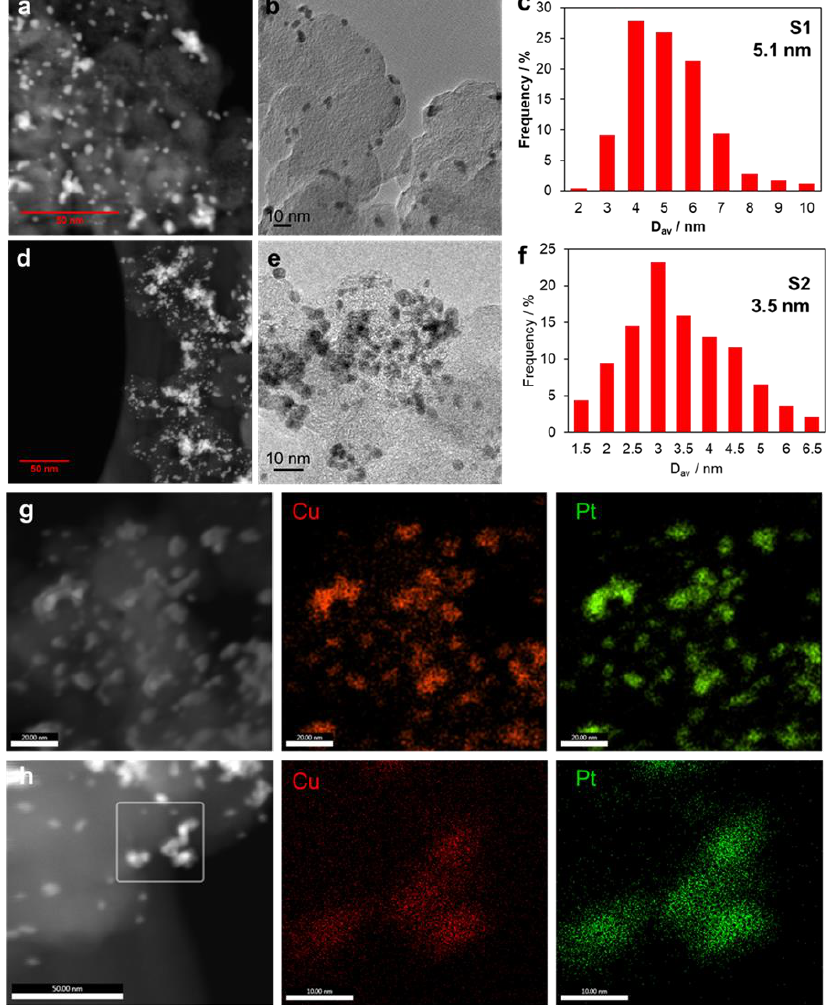
Figure 1. HAADF-STEM ( a , d , g , h ) and TEM ( b , e ) micrographs of the S1 ( a , b , g ) and S2 ( d , e , h ) samples; The NPs’ size distribution in the corresponding materials ( c , f ); The elemental mapping of Cu and Pt in the presented area ( g , h ).